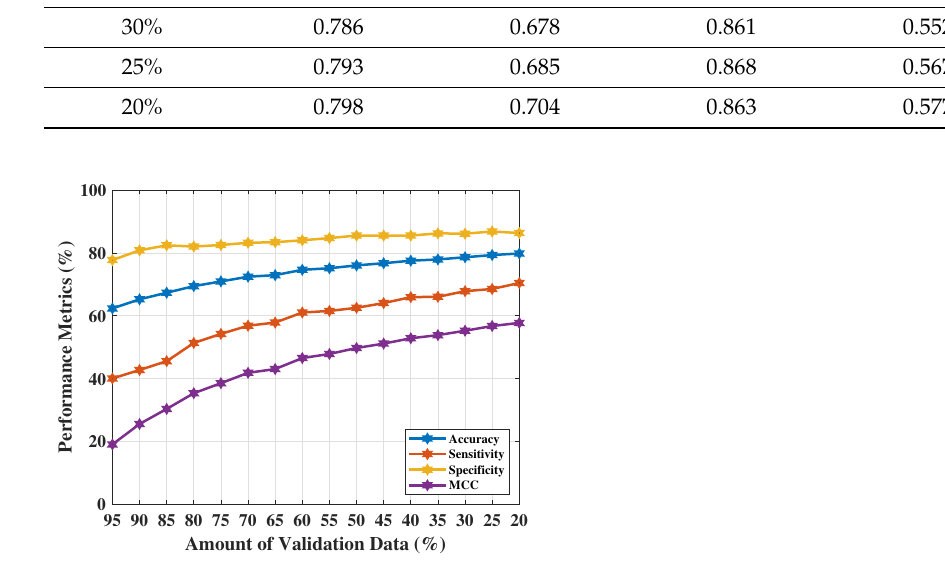
Figure 6. NF and WF signal prediction results (accuracy, sensitivity, specificity, and MCC ) obtained using real parts of MammoWave’s complex S 21 signals applying SVM G over different amount of validation